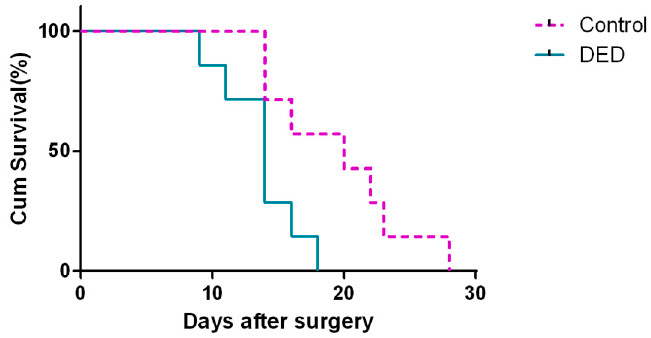
Figure 8. Bleb survival curves in the two groups. A Kaplan–Meier analysis showed that the survival distributions were significantly different between the control and DED groups ( p < 0.05).